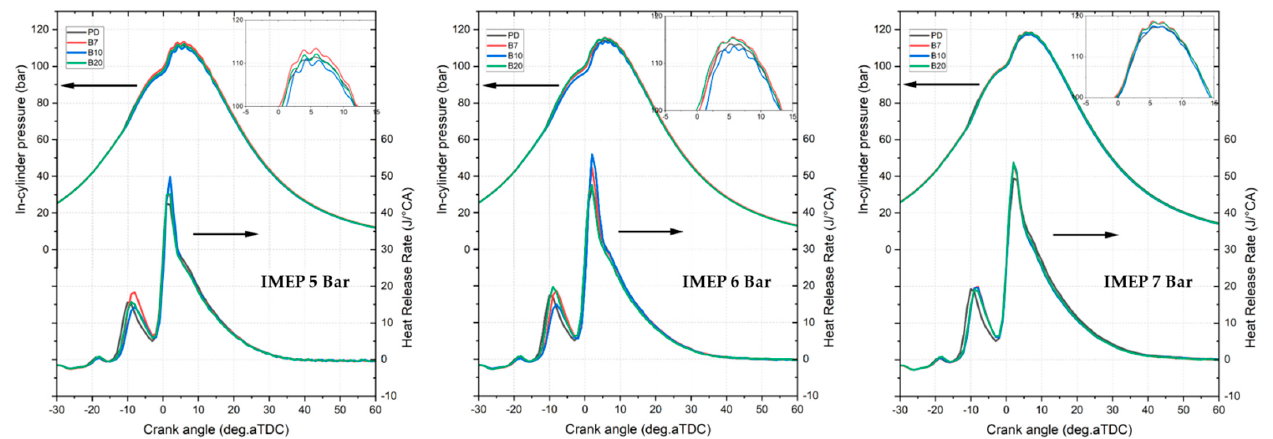
Figure 2. In-cylinder pressure and heat release rate profiles.